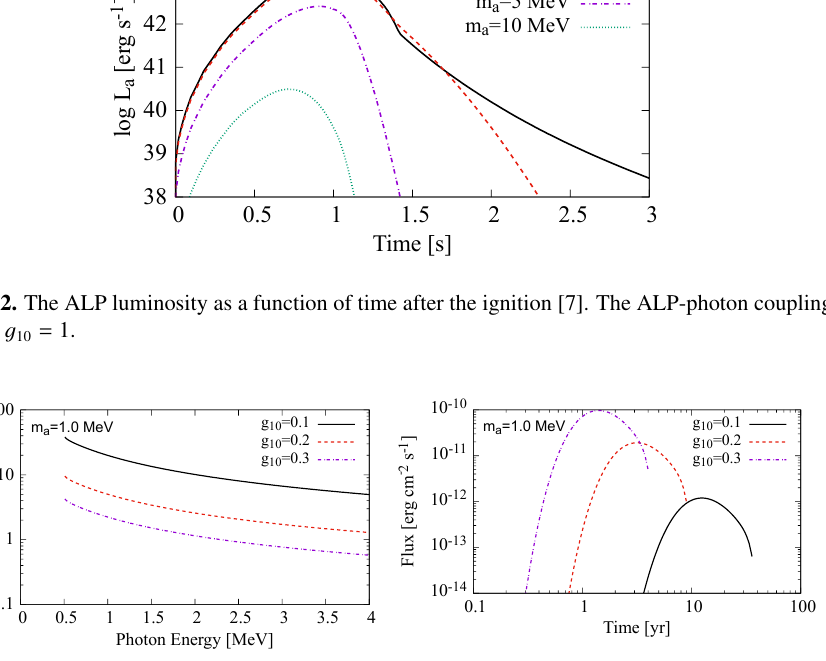
Figure 3. The delay time (left) and the energy flux (right) of decay photons from an SN Ia located 1 kpc away from the Solar System [7]. The ALP mass is fixed to m a = 1 MeV.